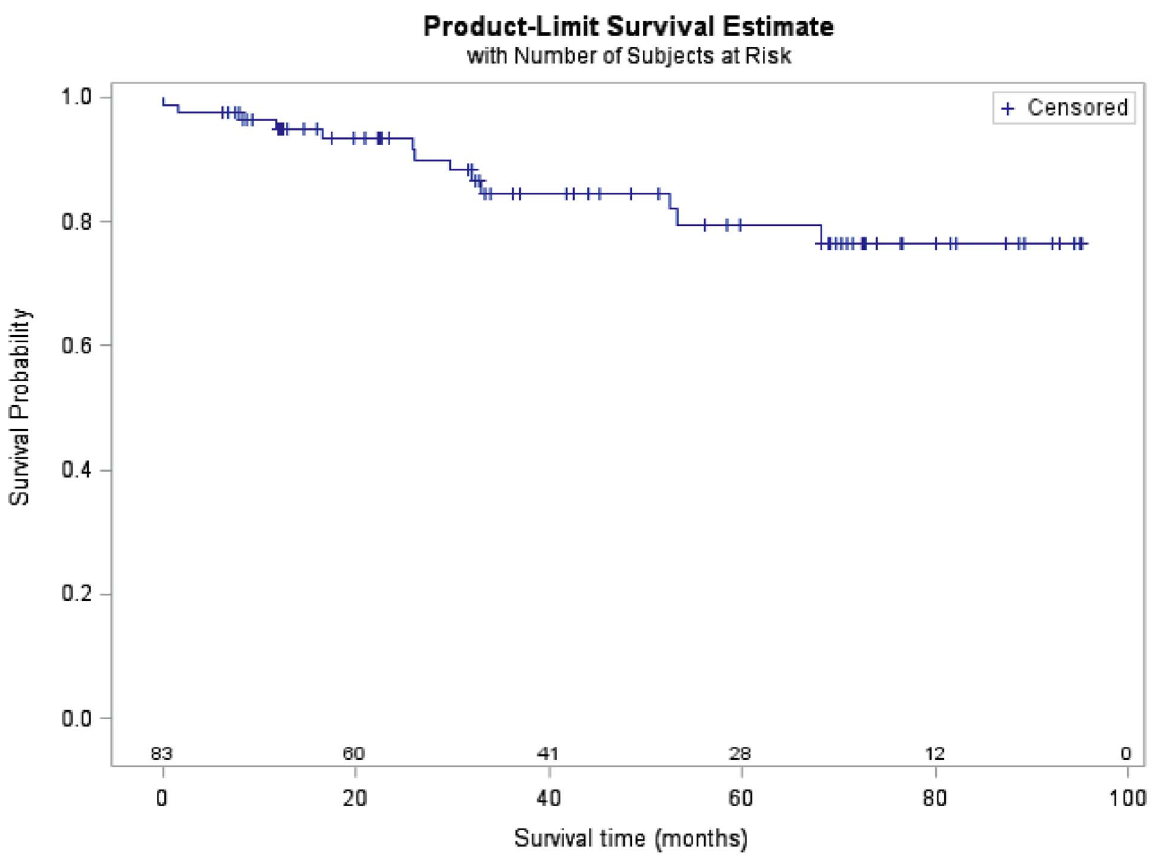
Figure 1. Survival curve for all children with pulmonary arterial hypertension. Kaplan-Meier curve displaying the overall survival in the studied cohort. The number of subjects at-risk are displayed along the